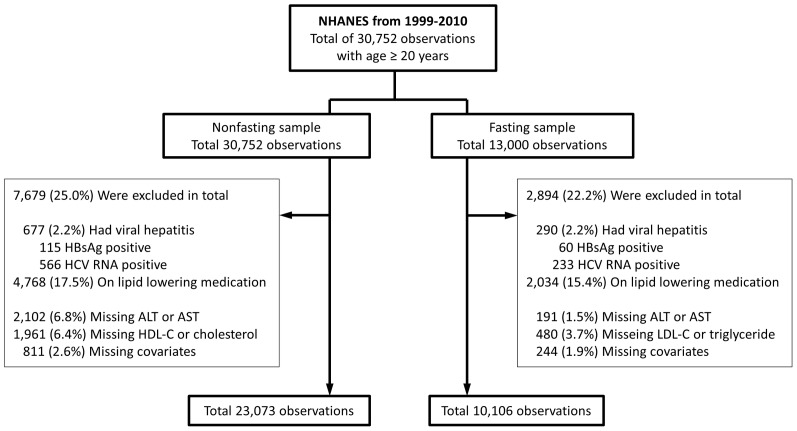
Description of eligible study participants.A total of 30,752 individuals aged 20 years or older were identified from NHANES from 1999 to 2010. Two separate datasets were generated for fasting and nonfasting lab values. In each dataset, participants with evidence of viral hepatitis B or C, currently taking lipid lowering medications, or missing lipoprotein, transaminase, or covariate measurements were excluded. This resulted in a nonfasting dataset of 23,073 observations and fasting dataset of 10,106 observations.